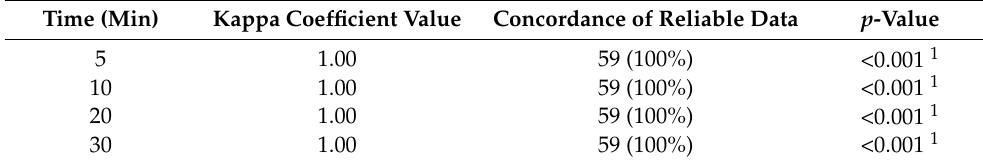
Table 2. Measurement of RBC and WBC agreement between fecal smears prepared with 10% isotonic formalin and standard method (the fecal smears prepared with 0.9% NSS) at different time intervals (n =